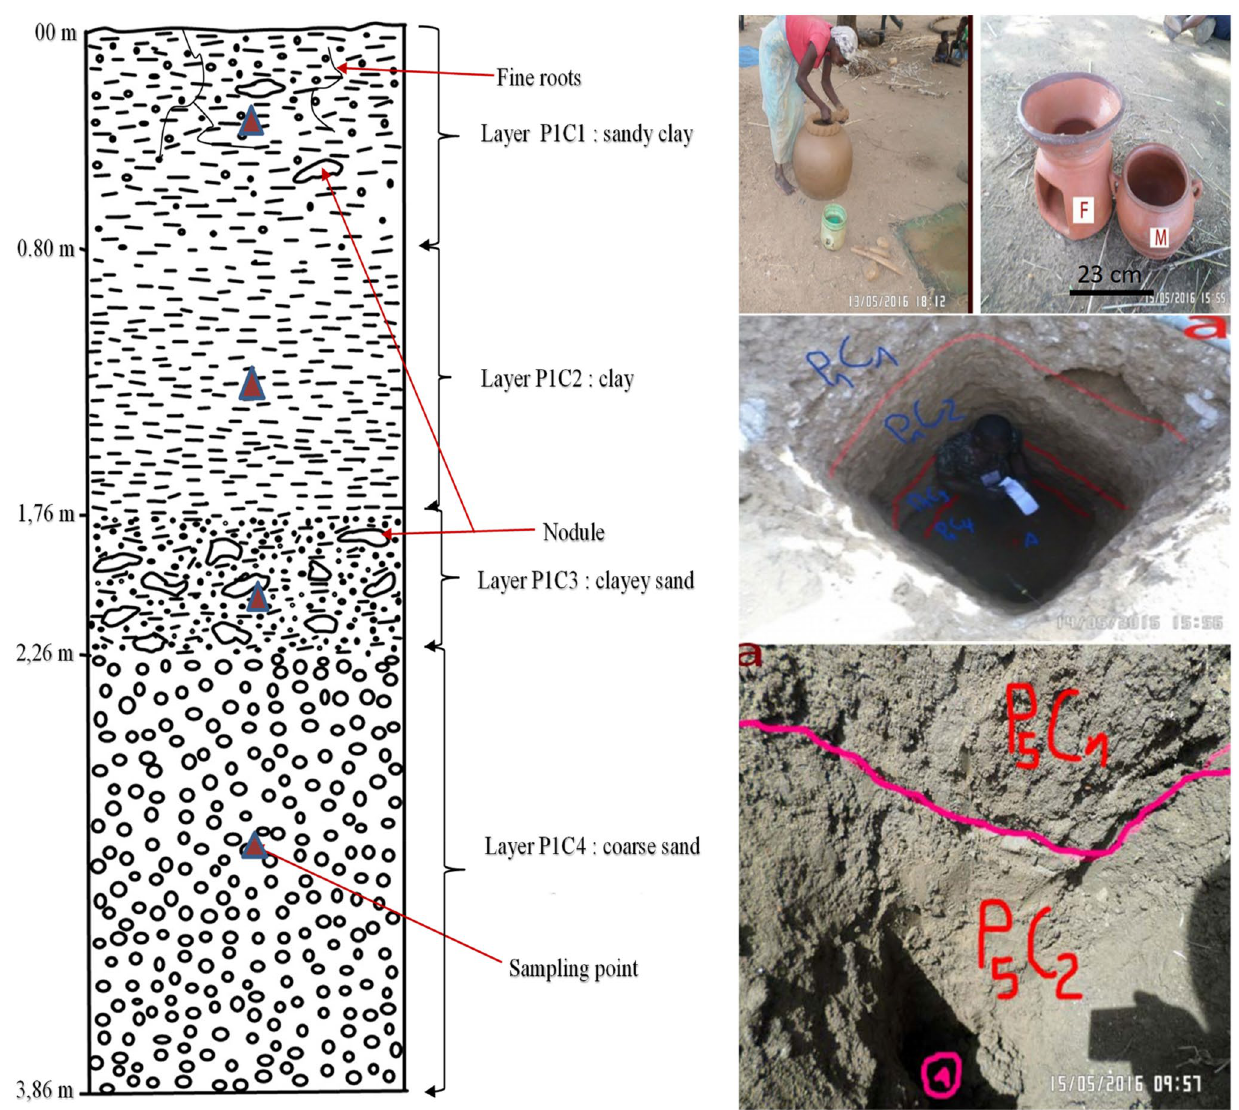
concentration in millimetric or centimetric nodules. Ceramic wood stove (F) and pottery (M) produced by the local population using clayey materials from